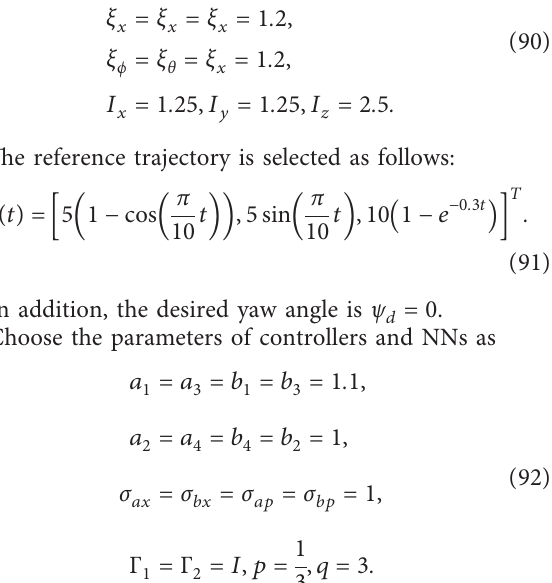
e d , and error x .